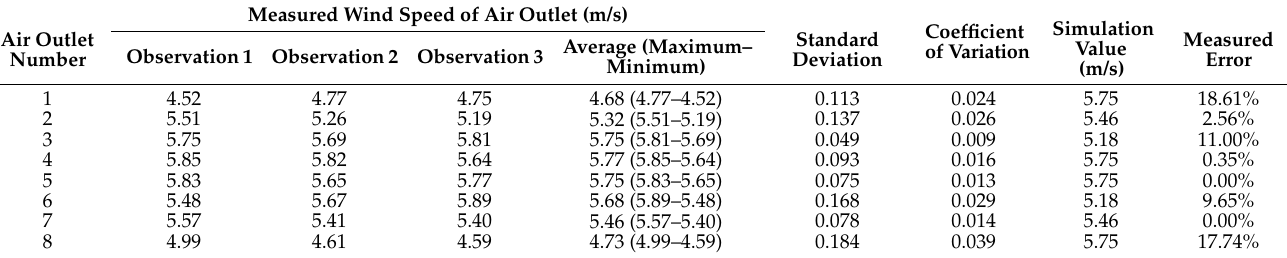
Table 5. Wind speed measurement of air